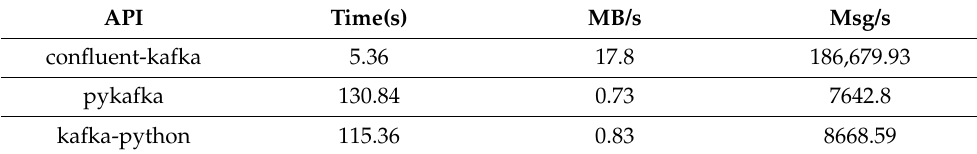
Table 2. Comparison of the throughput to Kafka consumer with three Python APIs.